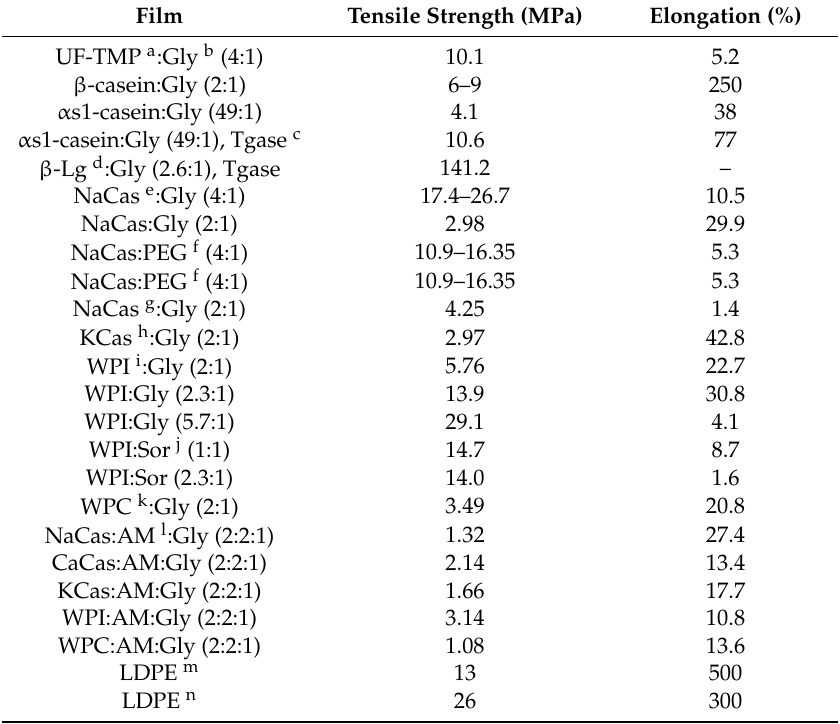
Table 8. Mechanical properties of various plasticized proteins